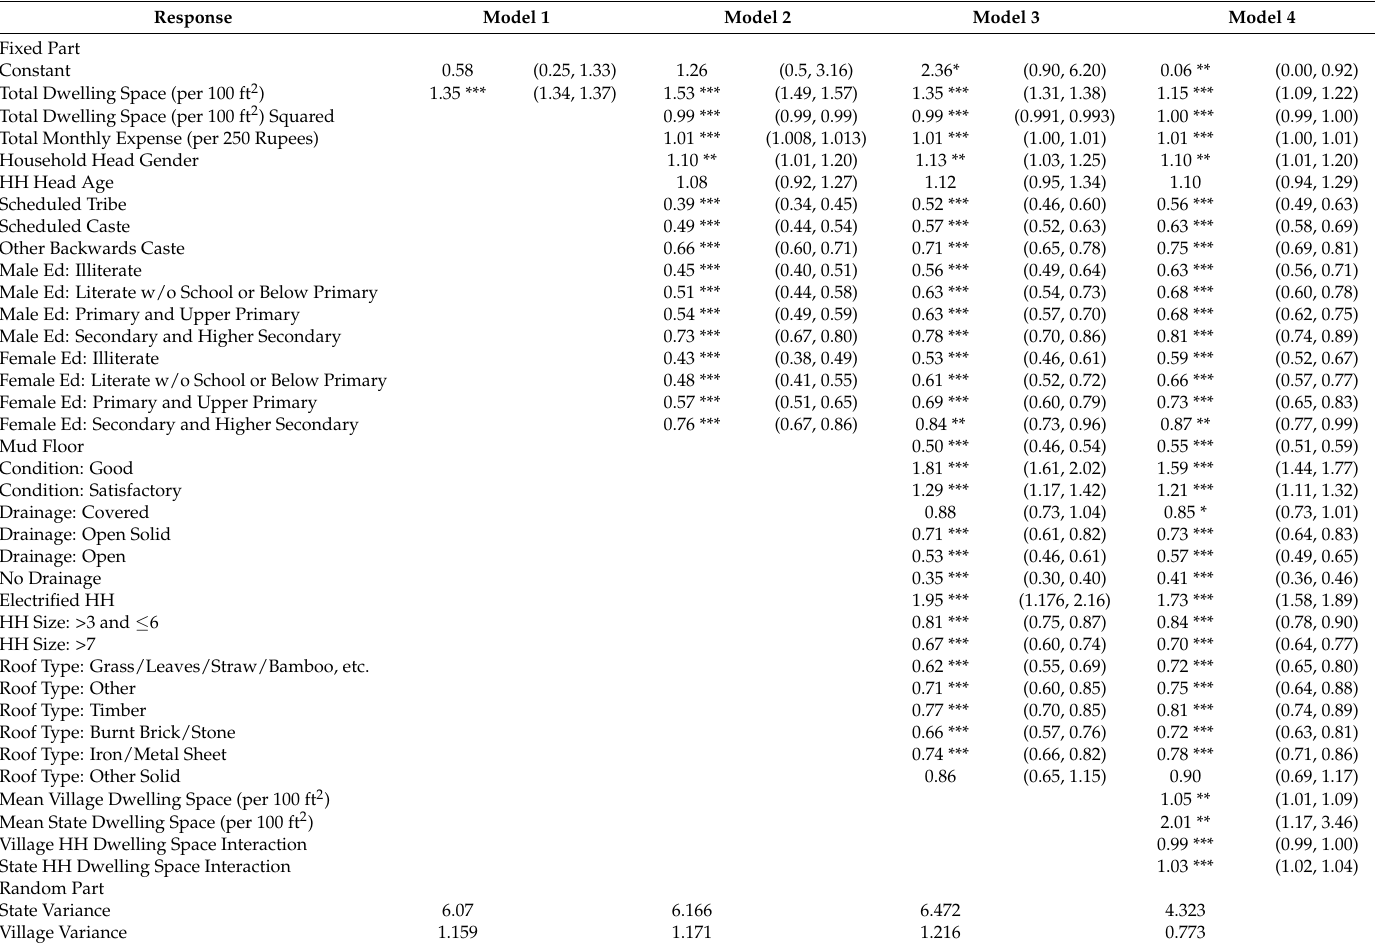
Table 2. Regression results (95% CI of OR in parentheses). *** p < 0.01, ** p < 0.05, * p <